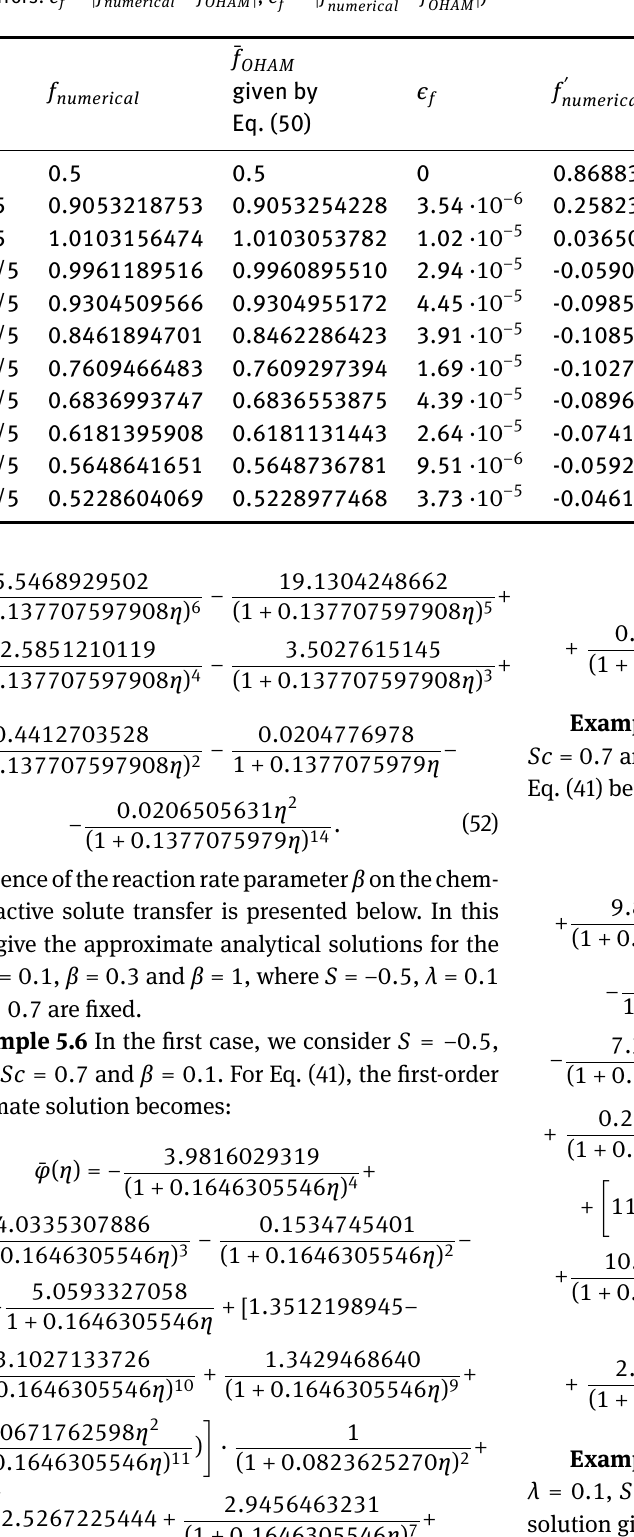
Table 4: Comparison between OHAM results ( ¯ f , ¯ f ′ ) given by Eq. (50) and numerical results, for S = 0.5 , λ = 0.1 (relative errors: ϵ f = | f numerical − ¯ f OHAM | , ϵ